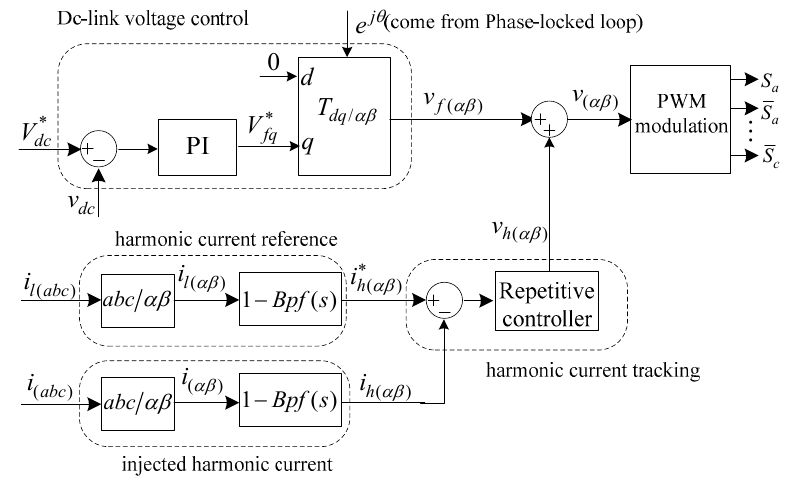
Figure 2. Overall block diagram of system control.